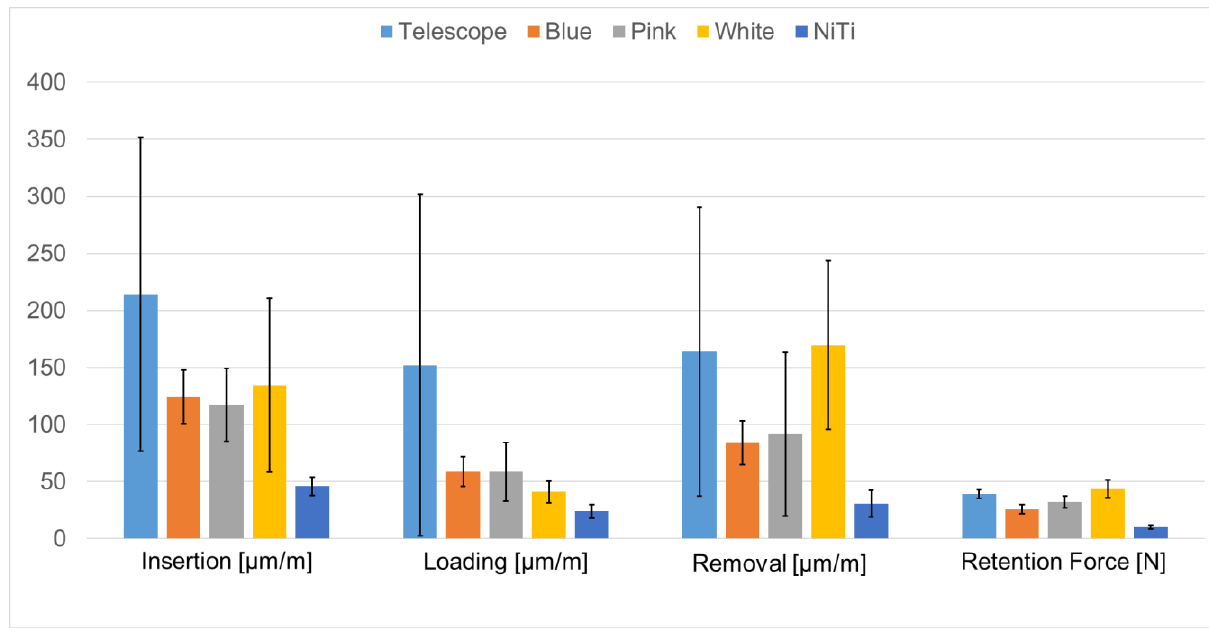
Figure 7. Mean of absolute strain values calculated for each attachment system and for each loading scenario (insertion, loading, removal) in addition to the mean retention forces of the prostheses.